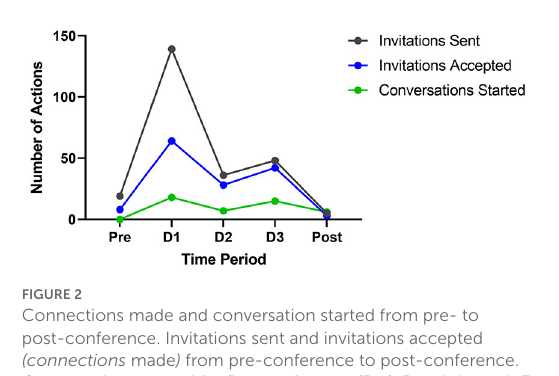
FIGURE2 Connections made and conversation started from pre- to post-conference. Invitations sent and invitations